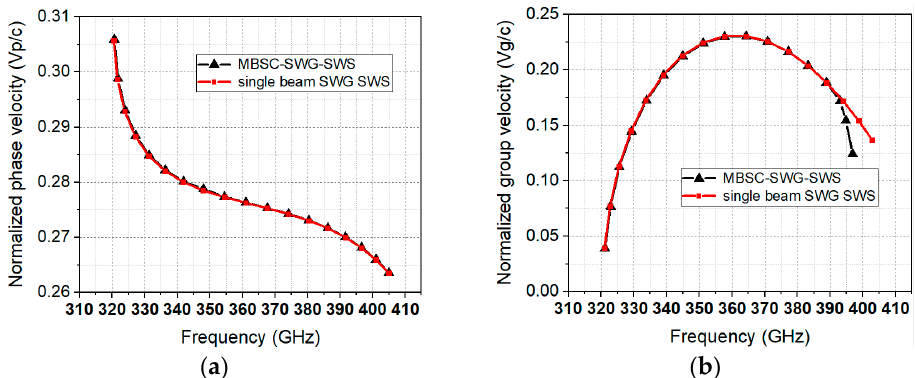
Figure 5. ( a ) Normalized phase velocity versus frequency. ( b ) Normalized group velocity versus frequency.